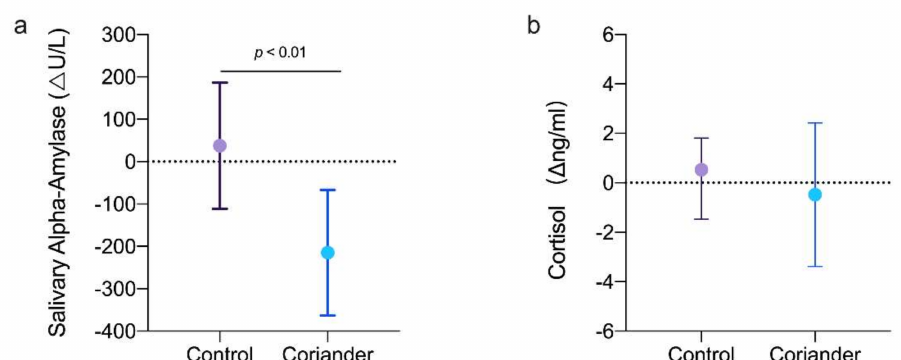
Figure 5. ( a ) Changes in salivary alpha-amylase ( ∆ ng/mL) between the coriander and control groups. ( b ) Changes in salivary cortisol ( ∆ ng/mL) between the group of coriander and control groups. Data presented as variation ± standard error ( n = 13). Independent t -tests were used to identify the significant differences between the two